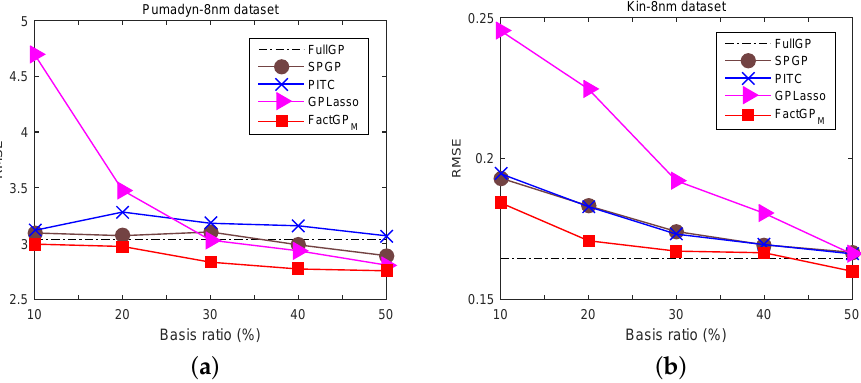
Figure 4. Errors of the proposed FactGP M and compared methods under various basis ratios for two regression problems: ( a ) Pumadyn; and ( b ) Kin. Note that the figure are borrowed from our preliminary work [24] (reproduced with permission from Eunwoo Kim, Sungjoon Choi, Songhwai Oh, Structured Low-Rank Matrix Approximation in Gaussian Process Regression for Autonomous Robot Navigation; published by IEEE,